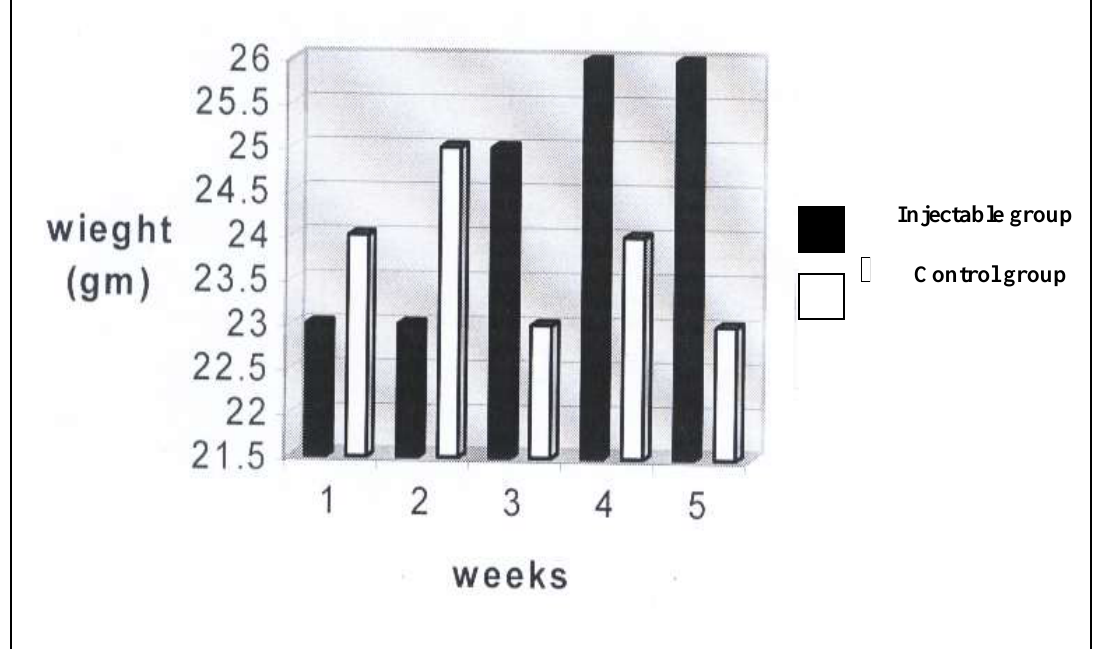
eeffffeecctt ooff iinnssuulliinn oonn lloooossiinngg oorr iinnccrreeaassee ooff aappppeettiittee.. EEssttiimmaattiioonn ooff ffoooodd wwaass ddoonnee bbeeffoorree aanndd aafftteerr iinnssuulliinn iinnjjeeccttiioonn iinn ccoommppaarriissoonn wwiitthh ccoonnttrroollss ,, tthhaatt wwaass ddoonnee wweeeekkllyy ffoorr ffiivvee wweeeekkss FFiigg((22))tthhee pprreesseenntt ggrraapphh sshhoowweedd tthhee aaffffeecctt ooff ddaaiillyy iinnssuulliinn iinnjjeeccttiioonn oonn tthhee aavveerraaggee ffoooodd ccoonnssuummppttiioonn wwiitthhiinn ffiivvee ssuucccceessssiivvee wweeeekkss ..tthhee ggrraapphh sshhoowweedd ddeeccrreeaasseedd ooff ffoooodd ccoonnssuummppttiioonn wwiitthh ccoonnttiinnuuiinngg ttrreeaattmmeenntt ,, wwhhiillee iinnccrreeaassee ffoooodd ccoonnssuummppttiioonn iinn uunnttrreeaatteedd c c o o n n t t r r o o l l s s .